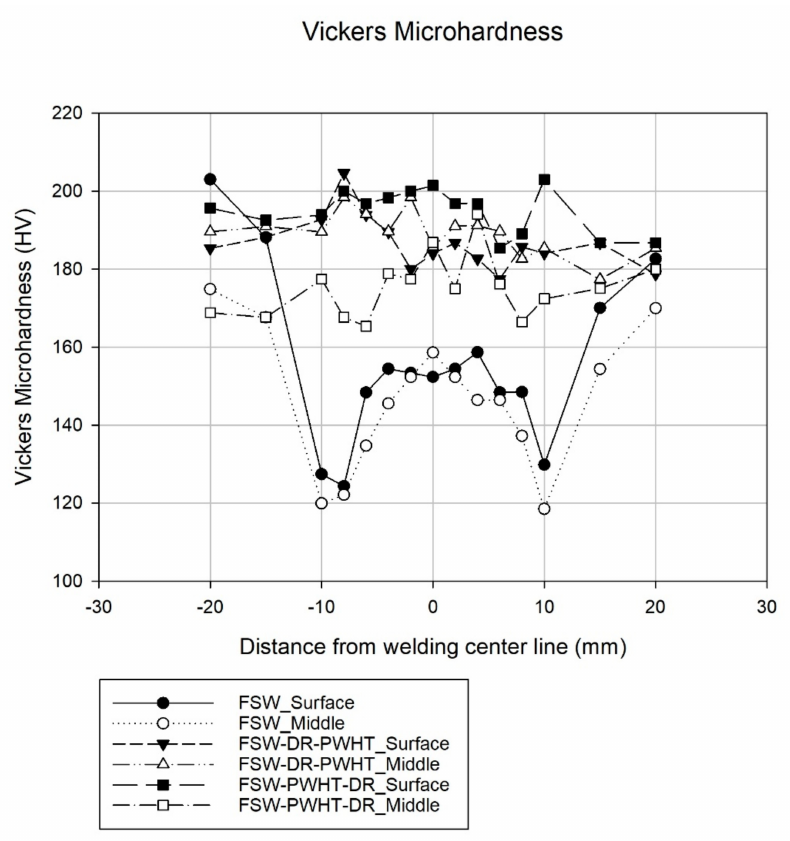
Figure 13. Vickers microhardness test